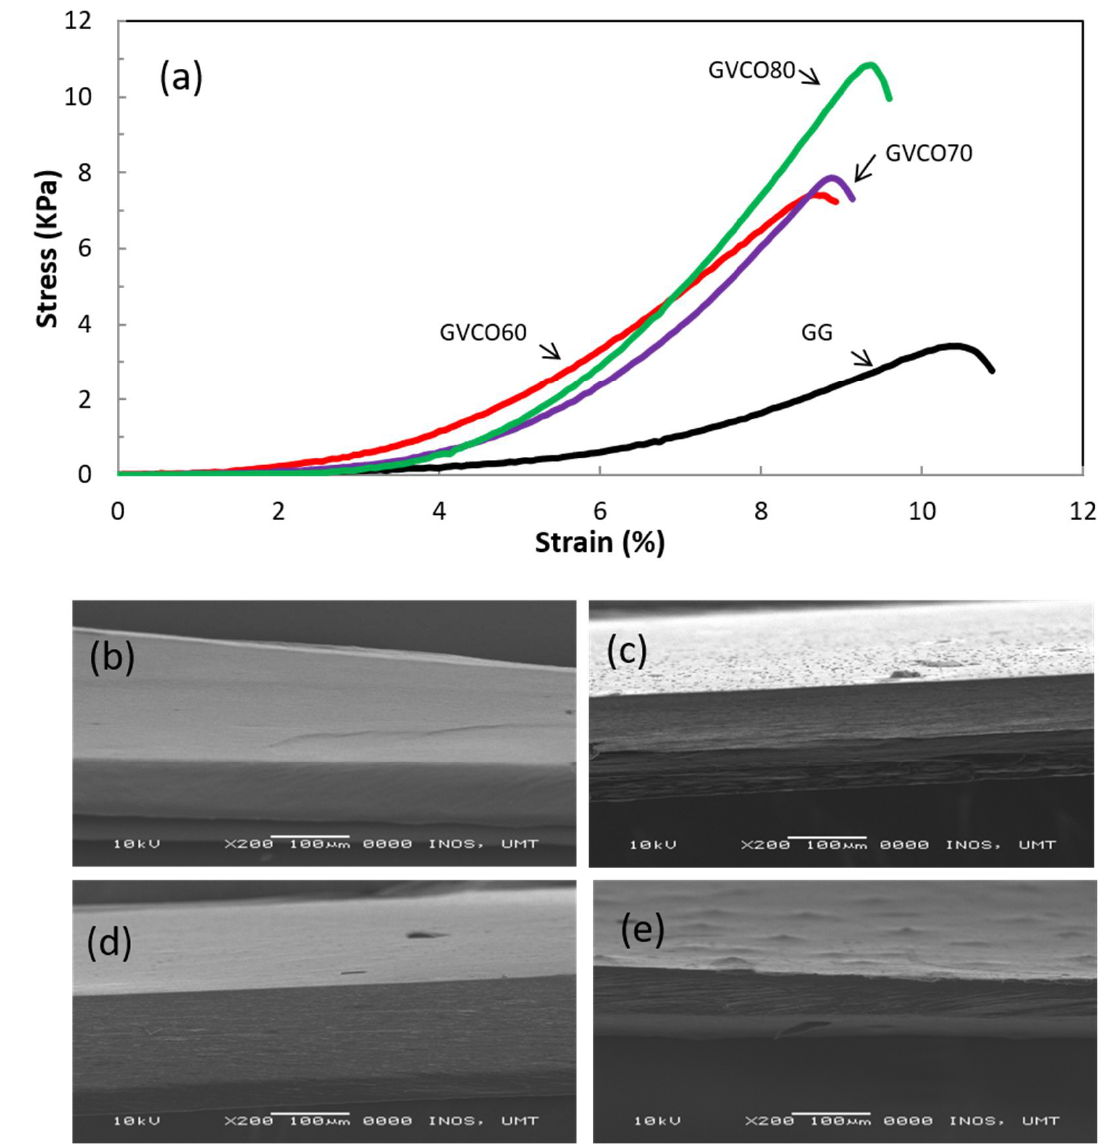
Figure 4. ( a ) Typical stress–strain curves of GG and GVCO hydrogels, ( b – e ) scanning electron microscopy images of the cross-sectional area of ( b ) pure gellan gum (GG) hydrogels, ( c ) GVCO60, ( d ) GVCO70, and ( e ) GVCO80 hydrogels.